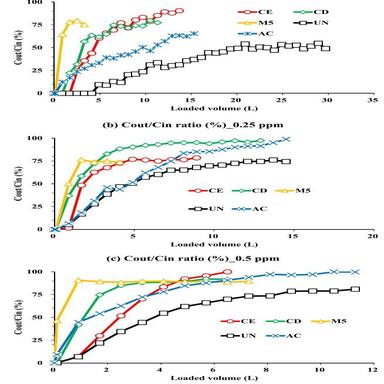
Breakthrough performances of the tested adsorbents toward low FA concentrations (0.1–0.5 ppm) (ambient temperature and 2 mg adsorbents).